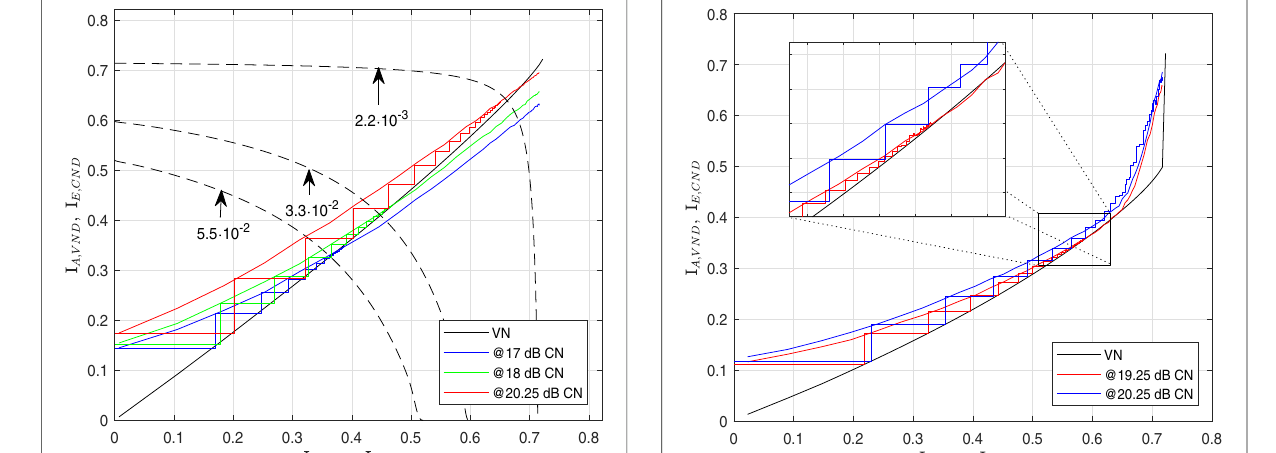
17, 18, and 20.25 dB, and for a non-uniform source with entropy H ( p 0 ) = 0.72 ( p 0 = 0.8). Notice that the vari- able node curve (which is valid for all SNRs) ends at the point ( H ( p 0 ) , H ( p 0 )) as it should be. Also plotted in the figure are the Monte Carlo simulated mutual information trajectories of this code with block length K = 37000 (and M = 10000). Each trajectory is plotted using the same color as their corresponding SNR’s EXIT chart CN curve, and they end where the corresponding CN and VN curves intersect. In addition, the contour lines of the cor- responding simulated BERs are also shown. For example, at SNR = 17 dB, the BER of the code is 5.5 · 10 − 2 and, as observed, the blue curve of the EXIT chart intersects the VN decoder curve very close to the 5.5 · 10 − 2 con- tour line. Similarly, for SNR = 18 dB and 20.25 dB, the simulated BERs are 3.3 · 10 − 2 and 2.2 · 10 − 3 , respectively. Again, the intersections between CN and VN curves occur very close to the corresponding BER’s contour lines. Note however that none of these SNRs allow the channel to be open. As previously explained , RCM-LDGM codes substi- tute some RCM symbols with non-systematic LDGM QPSK modulated bits, with the goal to lower the error floor of the corresponding RCM code. Figure 5 shows the EXIT chart and mutual information trajec- tories for the RCM-LDGM code obtained by substi- tuting 200 RCM symbols by 200 LDGM coded binary ( v ) = 1) in the previous RCM symbols (with d LDGM configuration. Observe that by introducing these 200 LDGM coded bits, we avoid the previous intersection of the curves at SNR 20.25 dB, improving in this way the BER at 20.25 dB. The corresponding mutual information trajectory at